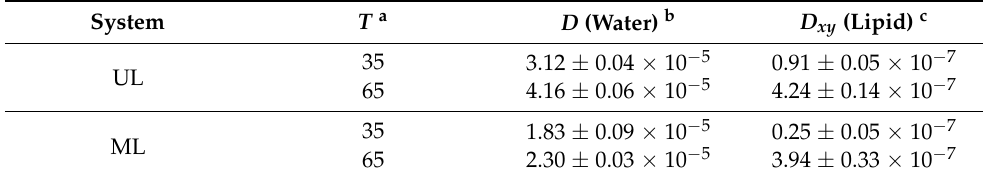
Table 4. Diffusion coefficients D for water and lateral diffusion coefficients D xy in unilamellar and multilamellar systems at different